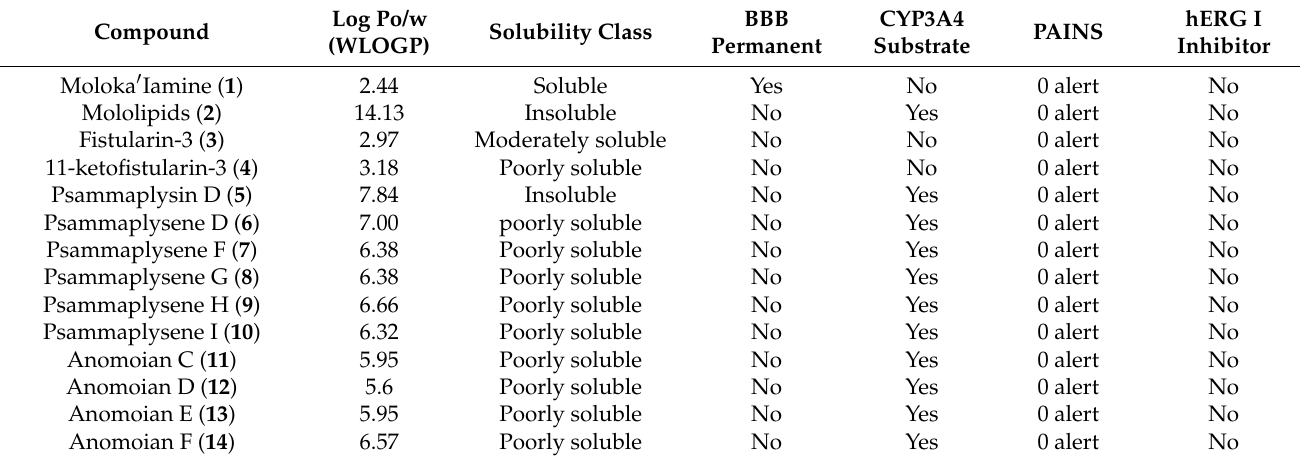
Table 3. In silico prediction of ADME/Tox profiles of the studied